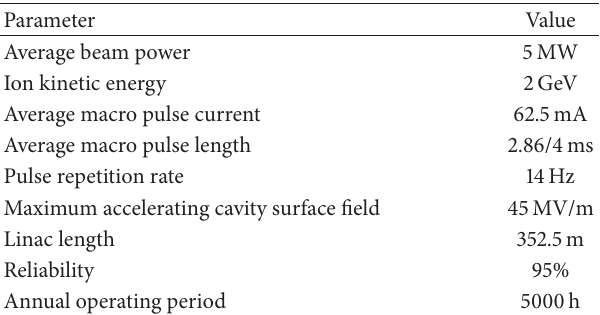
Table 2: Current main parameters of the ESS